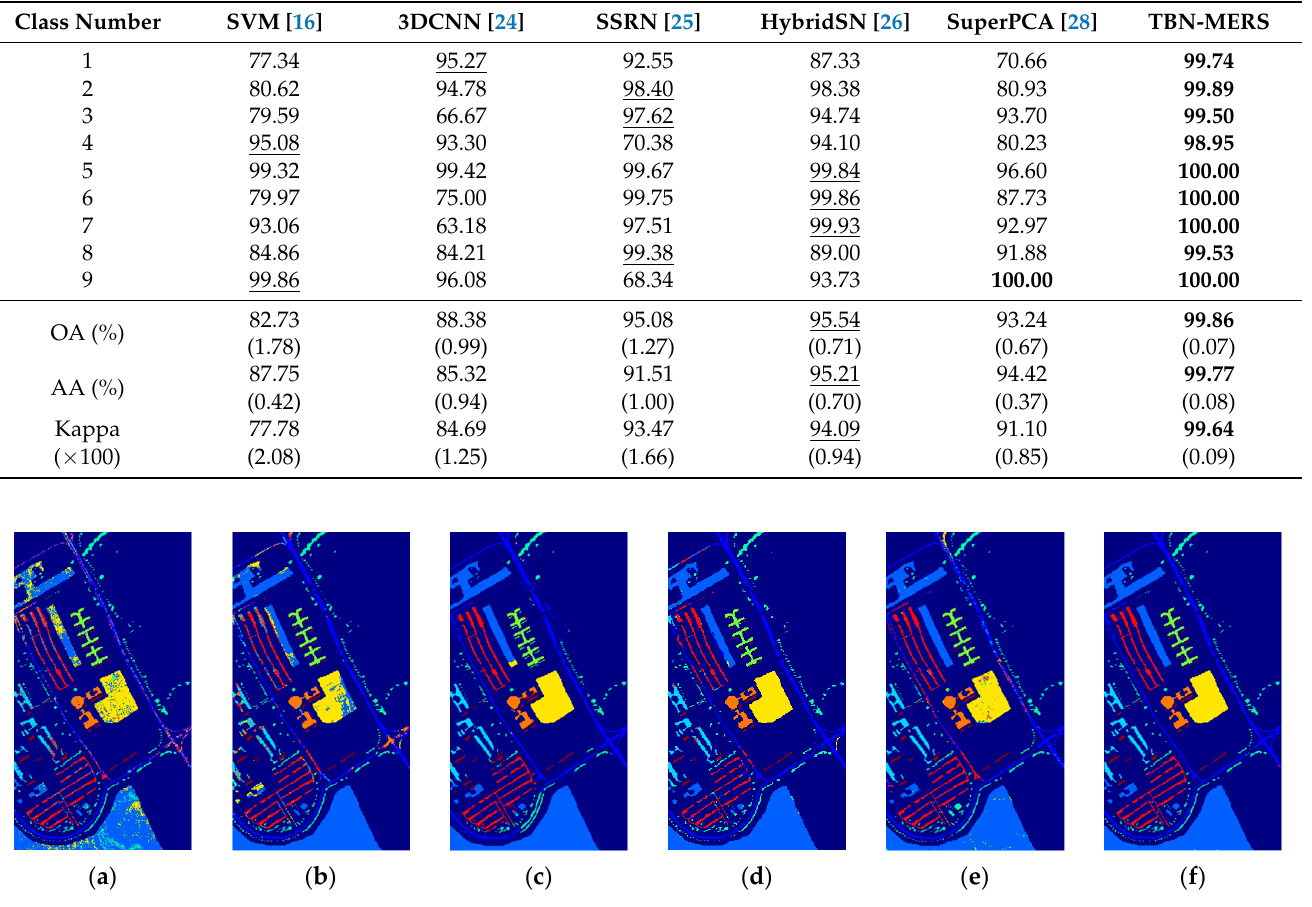
Figure 10. The predicted label images of different methods on PU: ( a ) SVM, ( b ) 3DCNN, ( c ) SSRN, ( d ) HybridSN, ( e ) SuperPCA, and ( f )